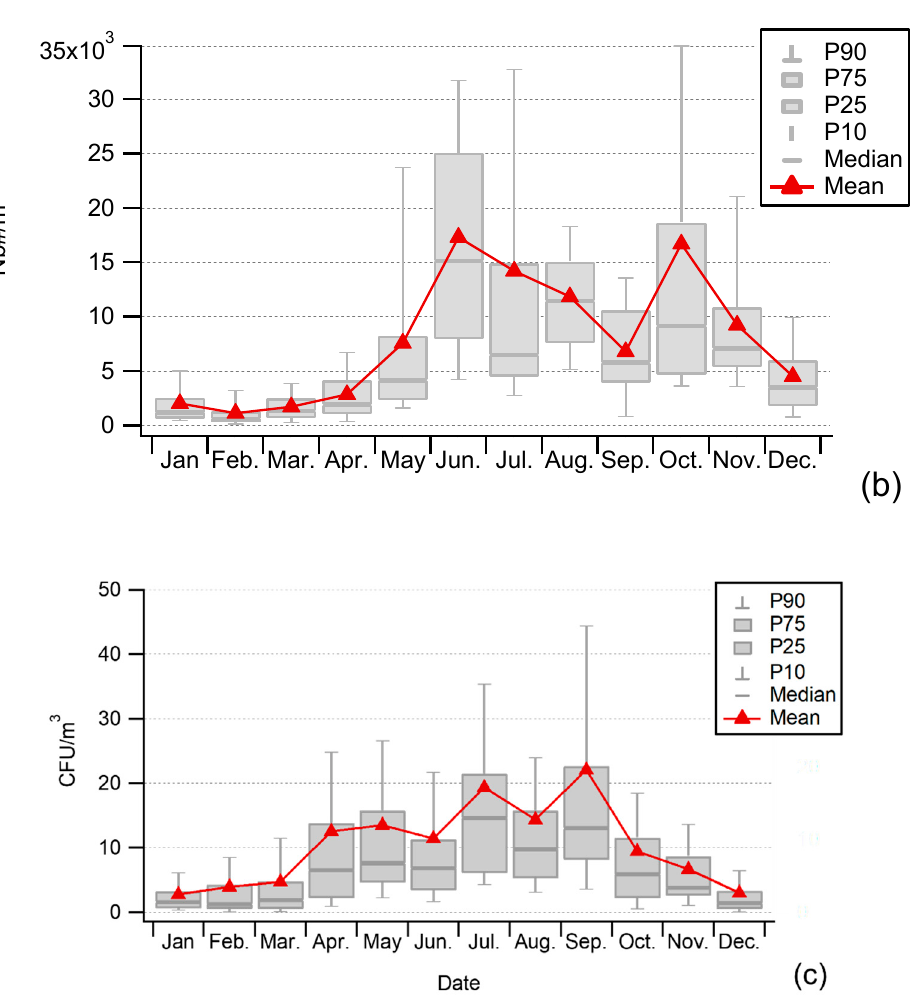
Figure 8. Seasonal variations of Airborne Pollen grains ( a ), Airborne Fungal Spores ( b ), and Airborne cultivable Bacteria ( c ) measured at Saclay observatory from 10 January 18 to 31 May 20.